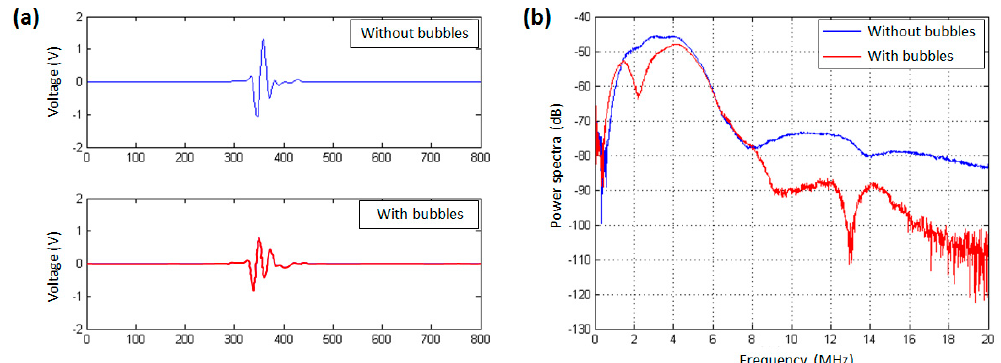
Figure 3. Received pulses obtained using a pair of focused transducers with a center frequency of 3.5 MHz. ( a ) Measured pulses reflected with a stainless-steel plate behind the sample chamber. The upper pulse comes from the reference measurement in the sample chamber without bubbles; the lower one is received from the transmitted pulse through the chamber with microbubbles. ( b ) The power spectra of the two received pulses.